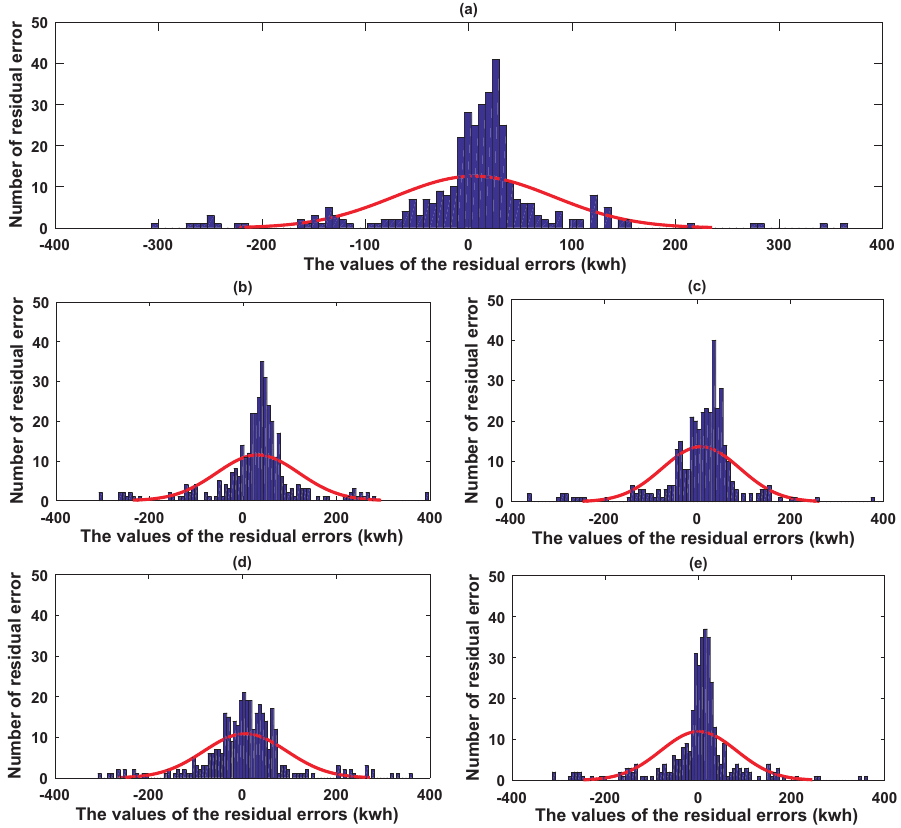
The values of the residual errors (kwh) Figure 10. Prediction error histograms of the five predictors constructed by utilizing the